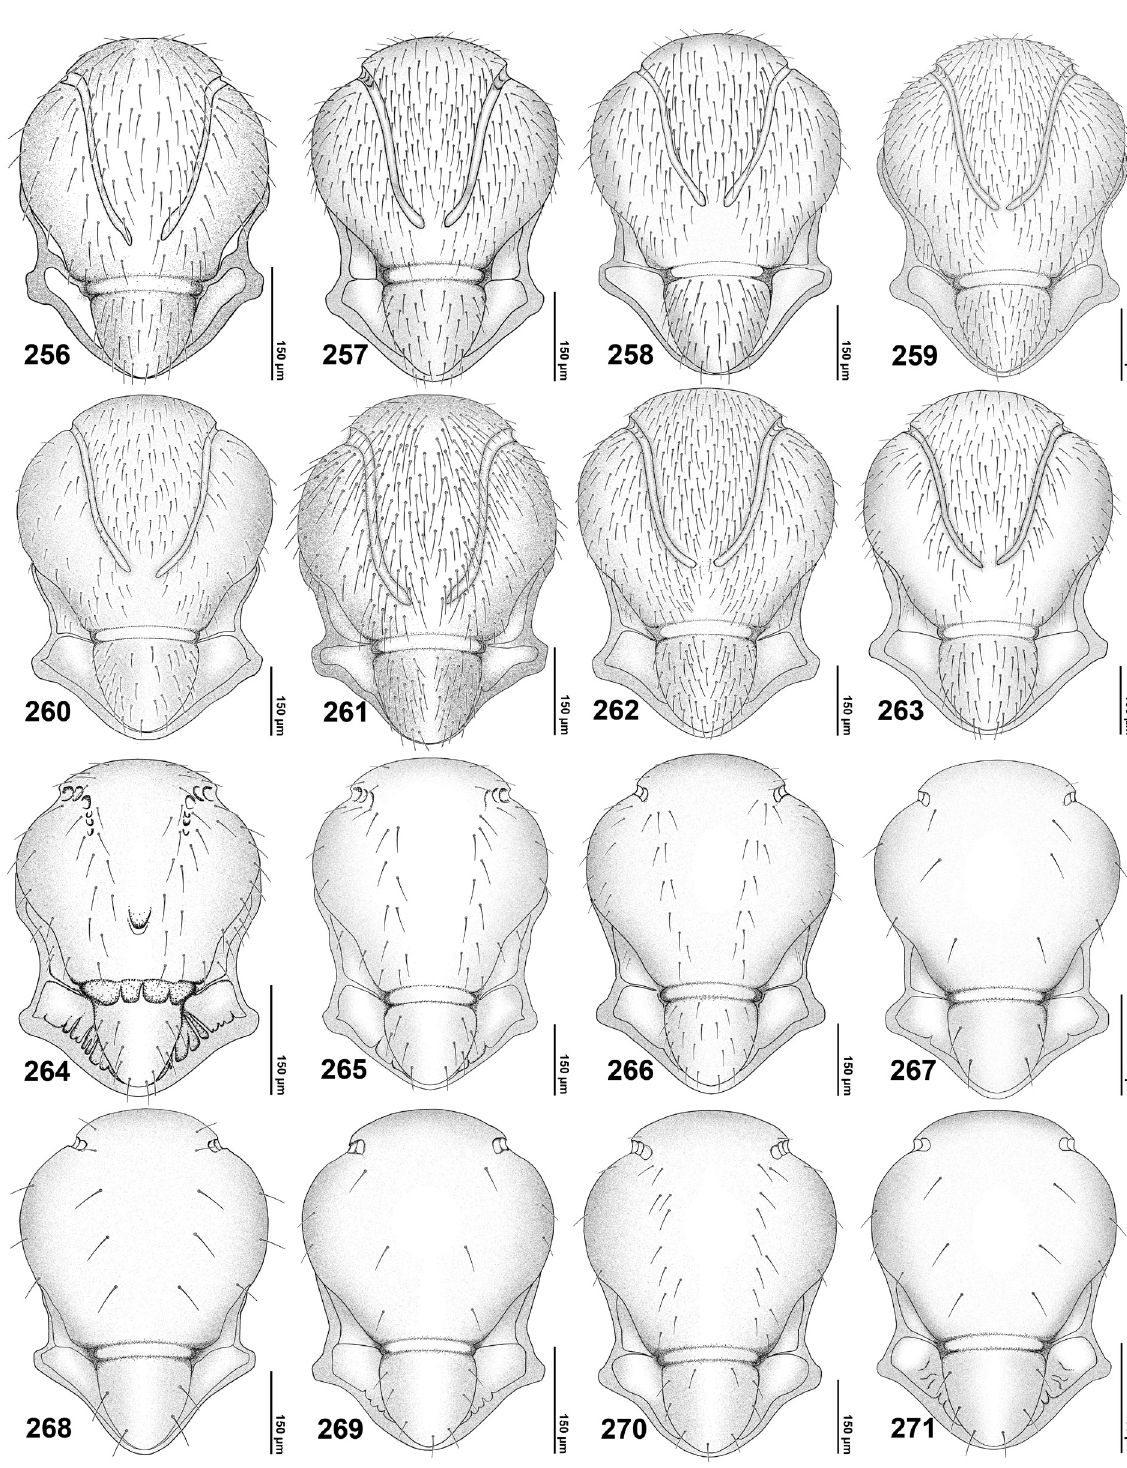
Figs 256–271. Dorsal aspect of mesonotum (♀): 256 . Praon nonveilleri . 257 . Praon orpheusi . 258 .